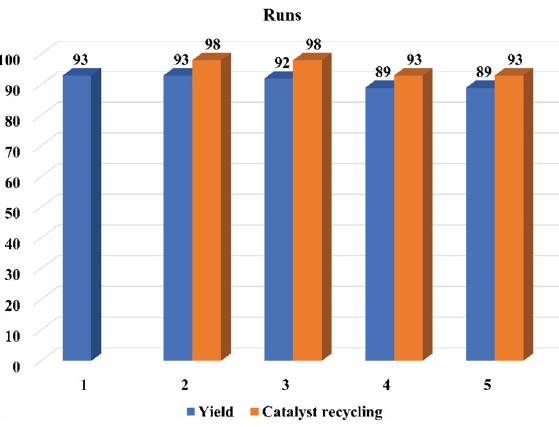
Figure 9. Recycling values for GO/f-SiO 2 /Co.